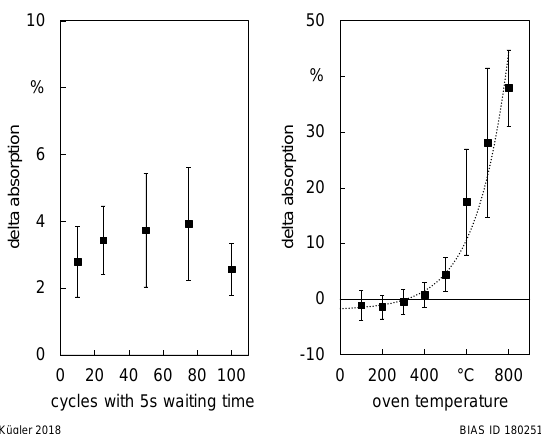
Figure 13. The absorption values influenced by multiple laser processing with a 5 s waiting time ( left ) and oven heating ( right ).